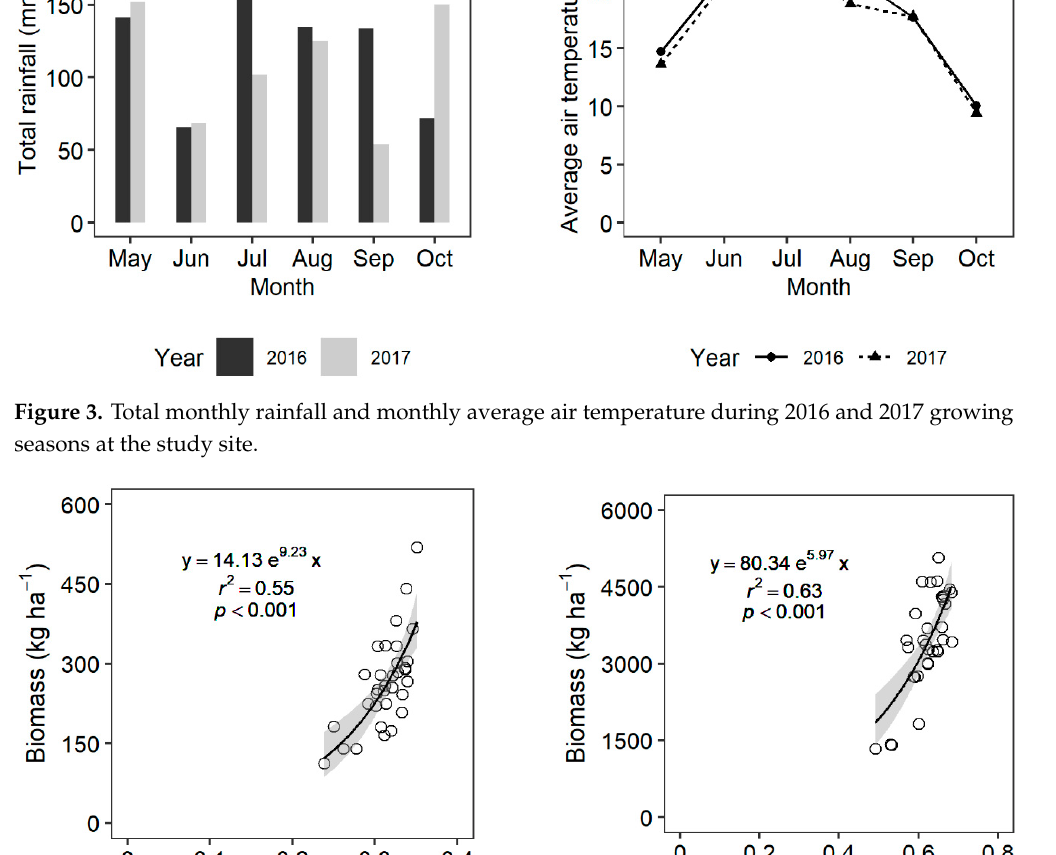
Table 2. Comparison of 2016 and 2017 monthly average air temperature (Tavg; °C) and total rainfall (Rain; mm) with historical averages at Lamberton, Minnesota, the United States.